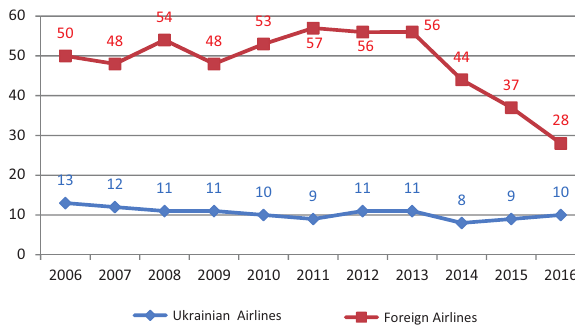
Figure 6. Number of Ukrainian and foreign airlines which